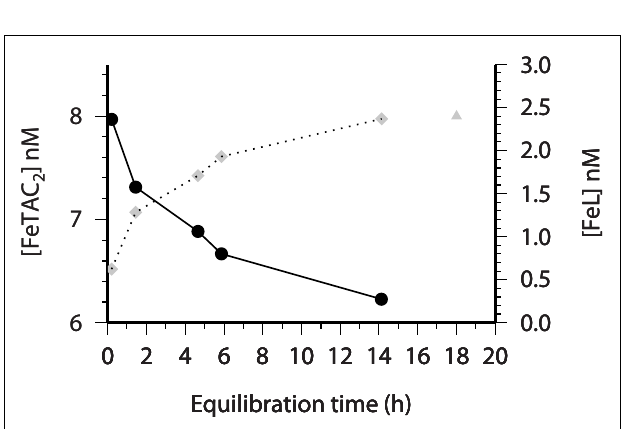
FIGURE 3 | CSV-KIN: time course of initial Fe(TAC) 2 (closed circles) concentrations, black circles (solid line) measured over the course of a 14h incubation experiment (at t = 0 Fe was added to the sample, at subsequent time points a subsample was removed,TAC added and the labile Fe measured by CSV). The corresponding FeL concentration, as determined by mass balance, is plotted as gray diamonds (dotted line).The gray triangle represents the [ L ] determined by the conventional thermodynamic CSV titration after 18h equilibration between the added Fe andTAC.Water sample is from 80m at Station 36 (see Table 1 for more details) during the Meteor 55 cruise.